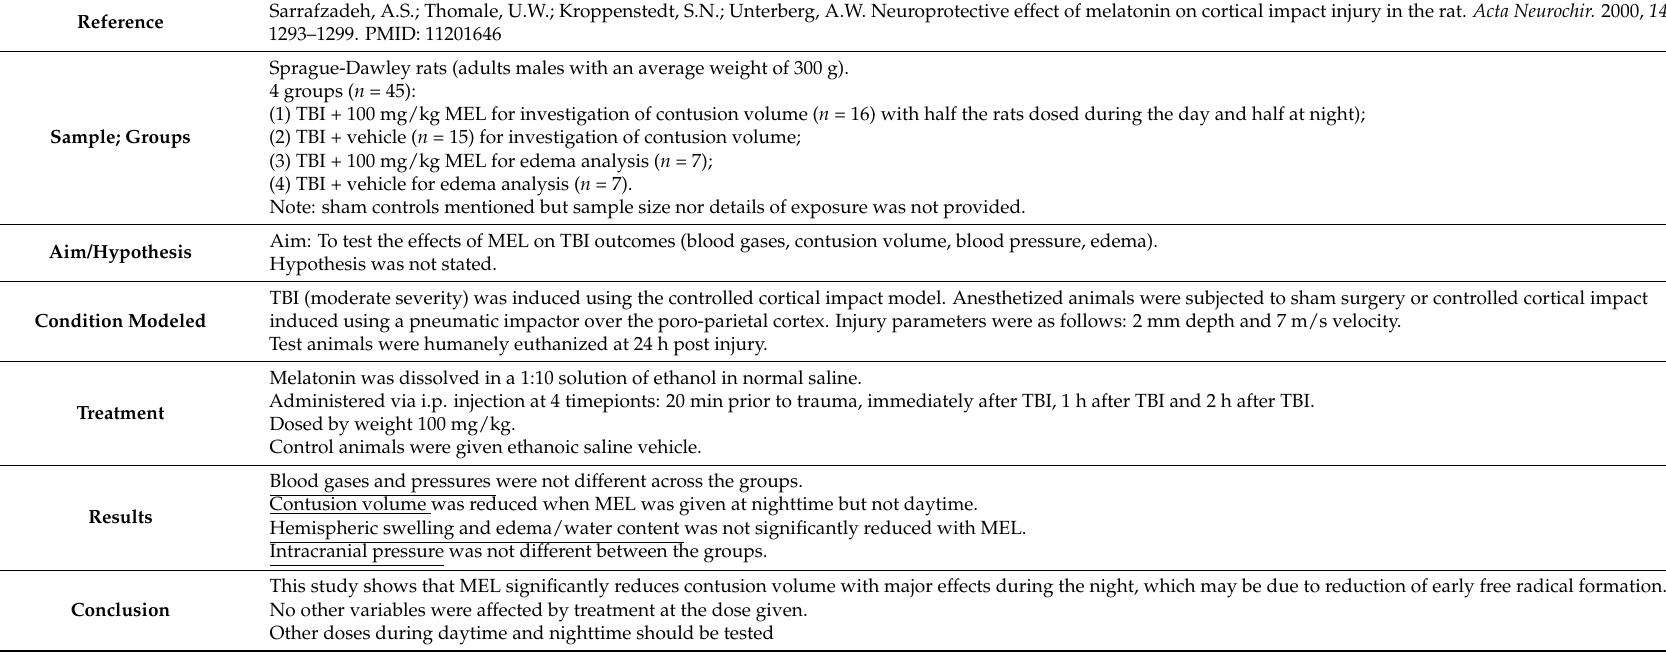
Table A3. Sarrafzadeh et al. (2000) Study